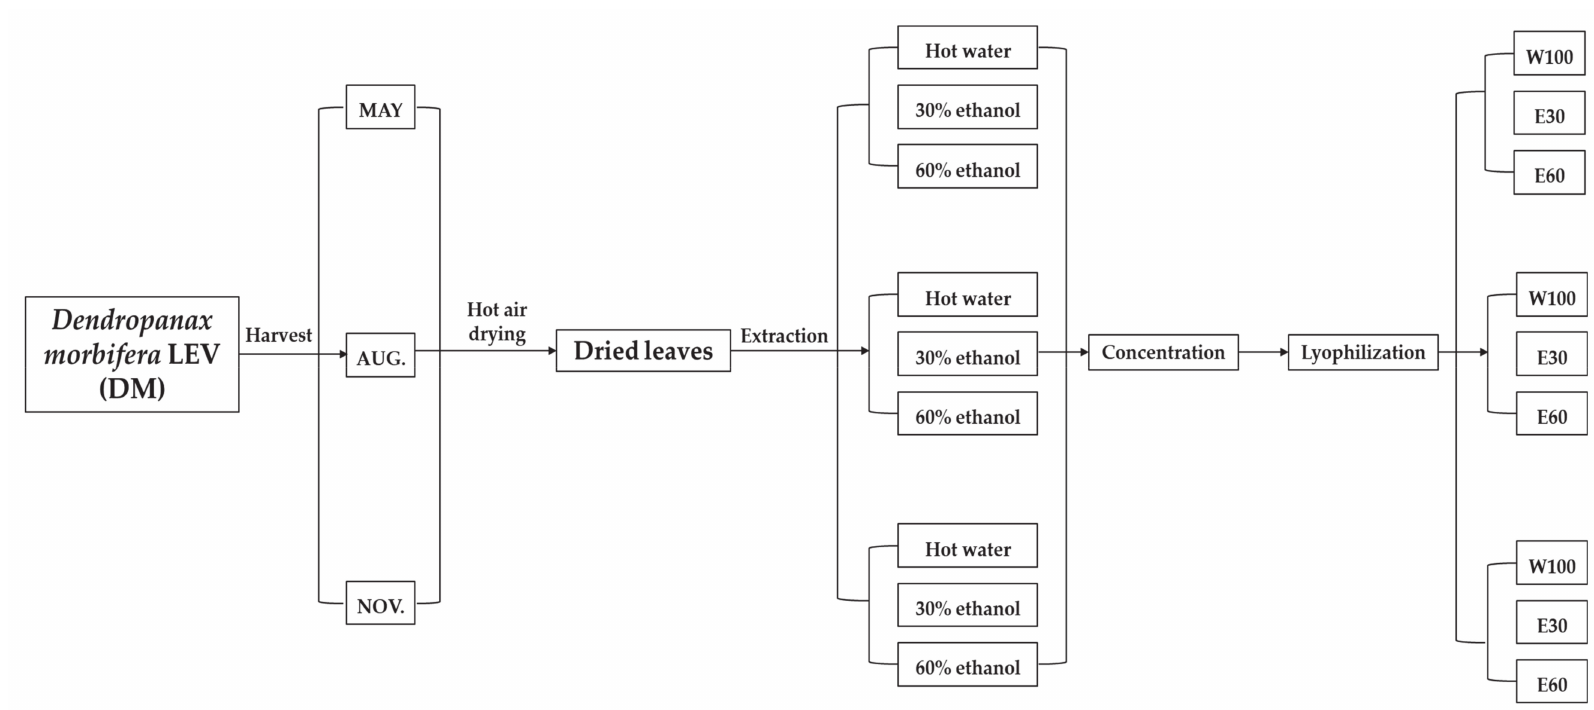
Figure 1. Preparation of Dendropanax morbifera extracts. W100, hot water extracts; E30, 30% ethanol extracts; and E60, 60% ethanol